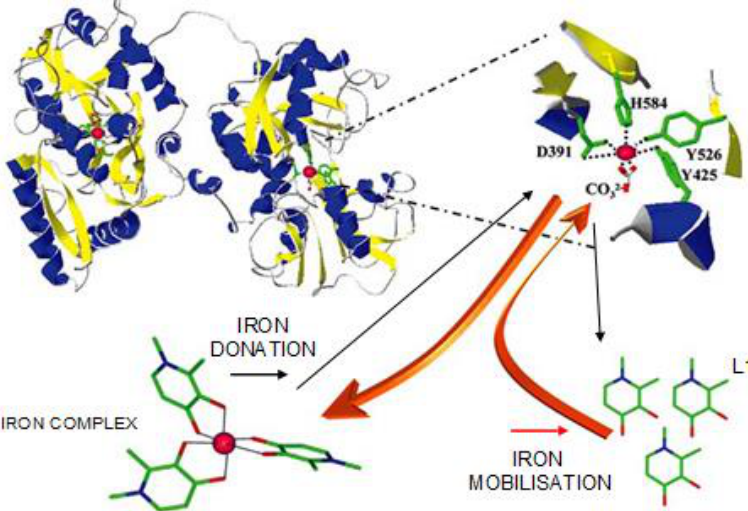
Figure 5. Interactions of L1 and L1 iron complex with the iron transport protein transferrin. Cartoon image of iron mobilization by L1 from diferric transferrin, which usually occurs in iron loaded patients and when high L1 concentration is present in plasma. In a reverse reaction, iron from the L1 iron complex can be donated to apo-transferrin increasing transferrin iron saturation. The latter reaction occurs in non-iron loaded patients with normal transferrin saturation treated with